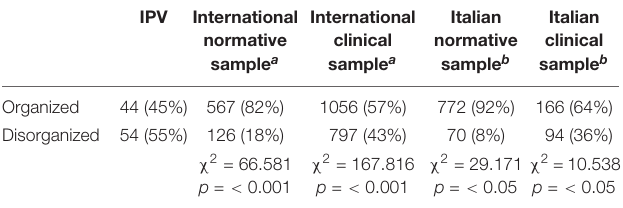
TABLE 7 | Comparison of AAI classifications (organized vs. disorganized) obtained by the IPV group with those of normative and clinical